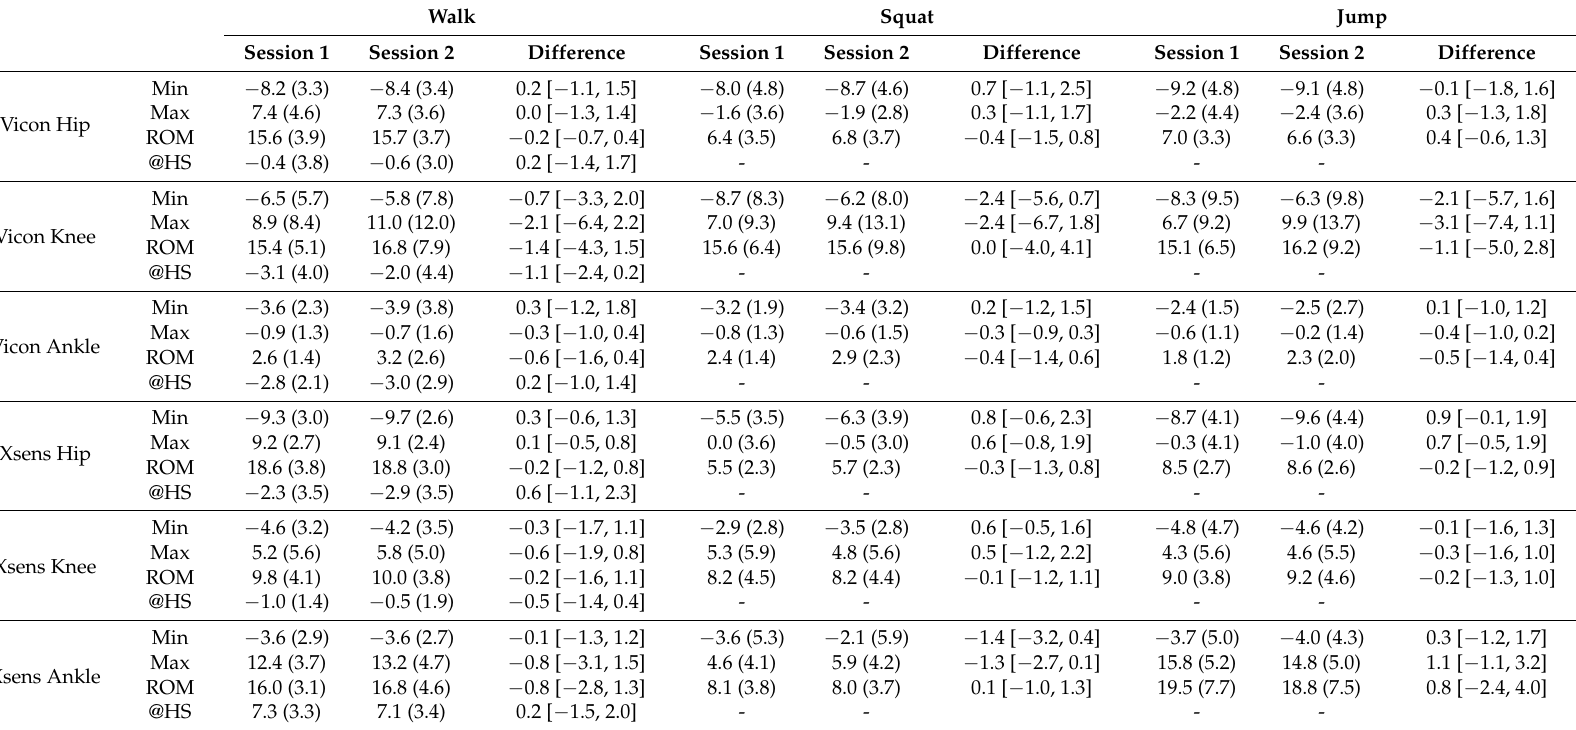
Data for each session are mean (standard deviation). Data for the difference are difference [95% confidence